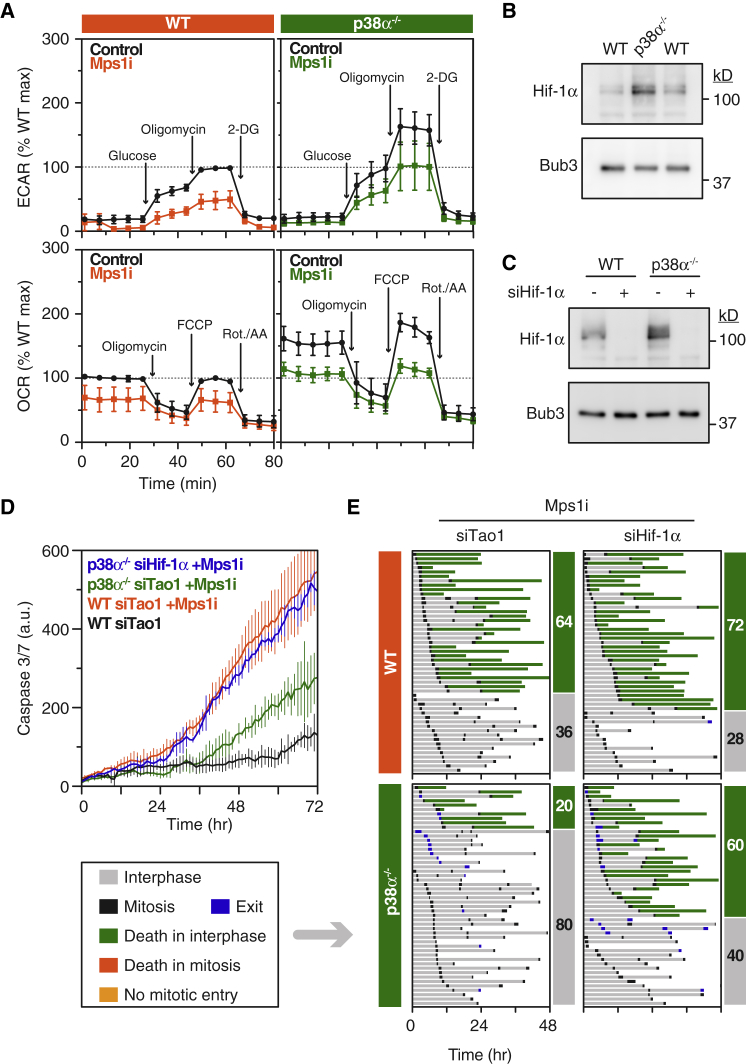
p38α Promotes Post-mitotic Apoptosis by Suppressing Hif-1α(A) Line graphs showing the extracellular acidification rate (ECAR) and oxygen consumption rate (OCR) in parental and p38α null cells after exposure to AZ3146 for 24 hr. Values show mean ± SEM from three independent experiments (see Table S1), normalized to the maximal value observed in untreated parental cells.(B) Immunoblot showing elevated Hif-1α in p38α null cells.(C) Immunoblot showing RNAi-mediated repression of Hif-1α; note also elevated Hif-1α in control p38α null cells.(D and E) Line graphs (D) and fate profiles (E) showing restoration of AZ3146-mediated apoptosis in p38α null cells following siHif-1α. In (D), values show mean ± SD from two technical replicates and is representative of three independent experiments.See also Figure S5.